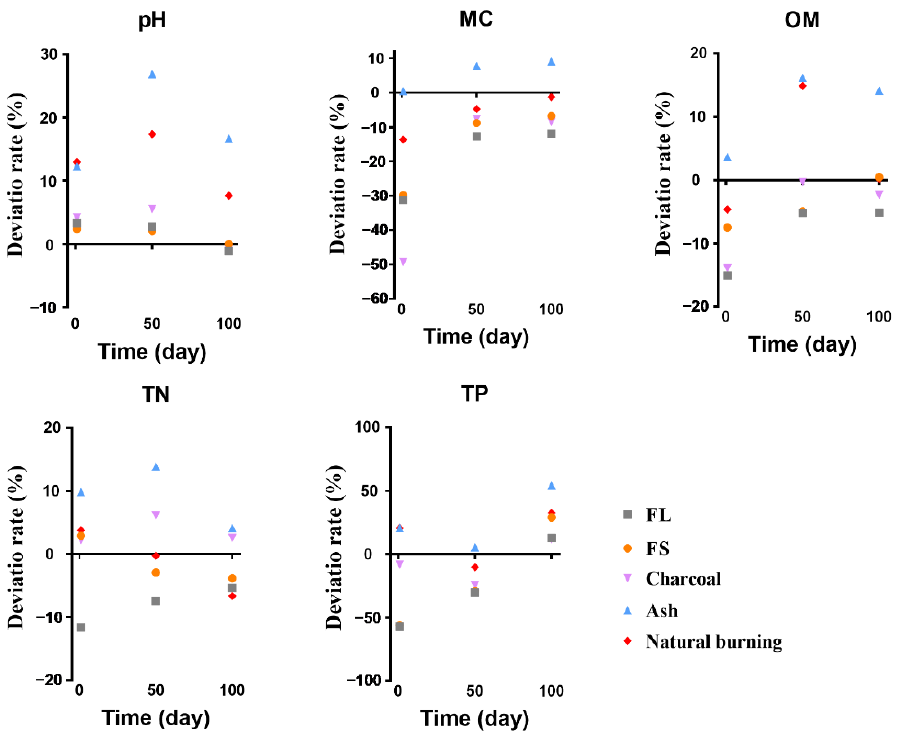
Figure 1. The deviation rate of soil chemical properties in the treatments when compared with Control. MC: moisture content; OM: organic matter; TN: Total nitrogen; TP: Total phosphorus. FS: treated with flame gun and the burn duration was 20 min; FL: treated with flame gun and the burn duration was 60 min; Charcoal: treated with Charcoal; Ash: treated with cooled ash; Natural burning: treated with dry pine needles placed directly on the soil and let burn naturally and ashes were left on the soil after burn; Control: without any disturbance.